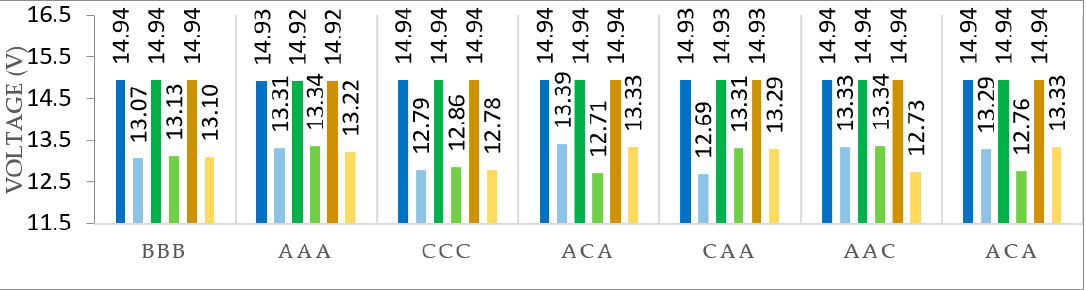
Figure 9. Voltage balance in CSCs depending on association at operating point N° 1 in IPOS config.